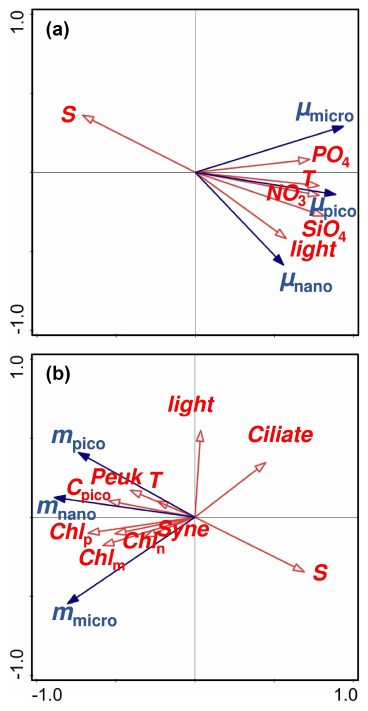
Figure 6. Redundancy analyses (RDA) representing (a) the re- lationships of the size-fractionated phytoplankton growth rates ( µ micro , µ nano , and µ pico ) with various environmental variables and (b) the relationships of the size-fractionated microzooplank- ton grazing rates ( m micro , m nano , and m pico ) with various environ- mental variables. Red arrows are environmental variables with blue arrows for rates; Chl m , Chl n , and Chl p are the chlorophyll a con- centrations of micro-, nano-, and pico-phytoplankton; C pico is the picophytoplankton carbon biomass with Peuk for picoeukaryote and Syne for Synechococcus